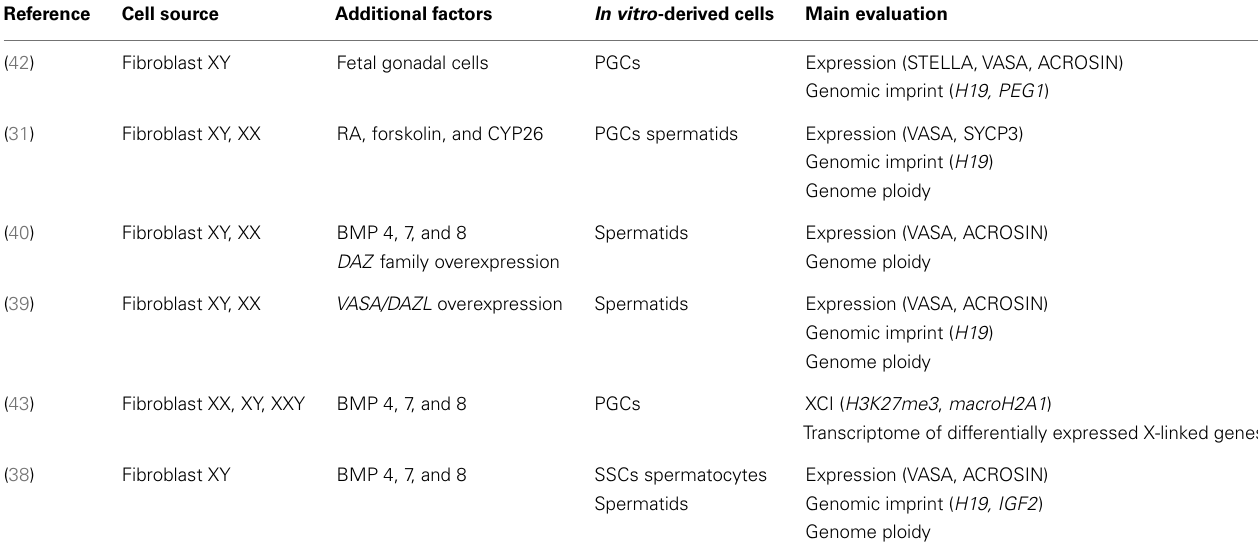
Table 1 | Differentiation of human iPSCs into male germ cell lineage